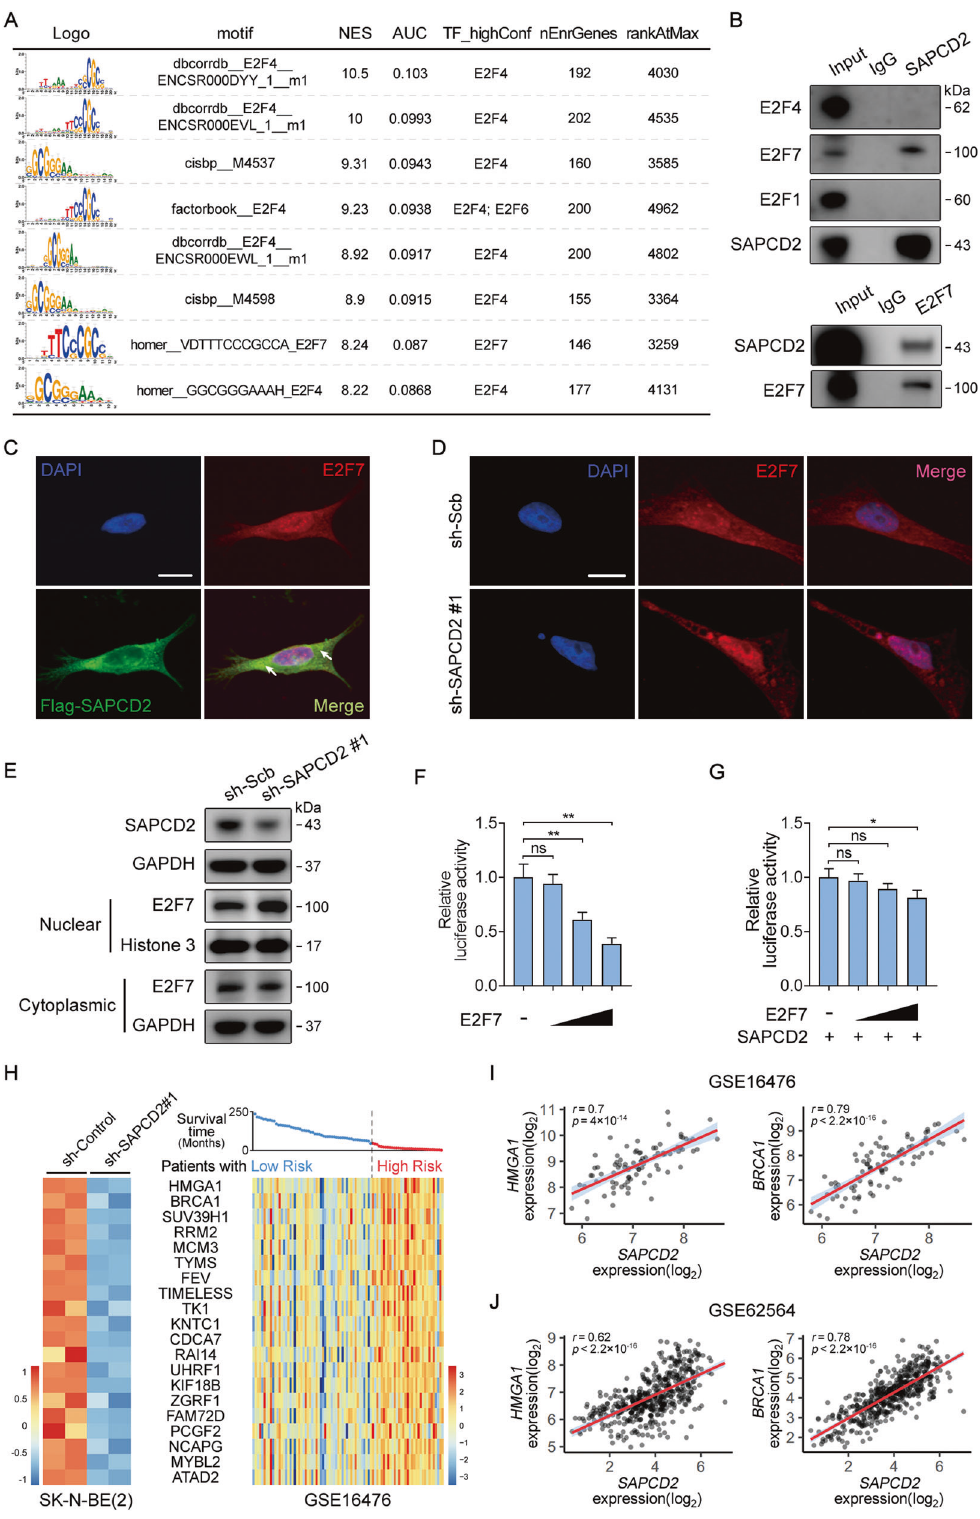
outcome of patients. We also discovered the signi fi cant correlation of SAPCD2 transcript levels with the degrees of CIN in NB as well as some other tumor types. In addition, our fi ndings indicated that SAPCD2 exerted oncogenic functions and promoted NB progression both in vitro and in